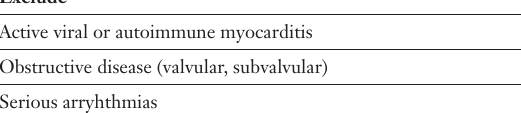
Inclusion and exclu- sion criteria for train- ing of chronic con- gestive heart failure patients.